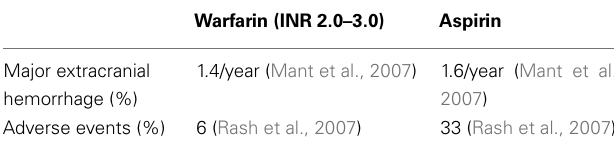
Table 2 |Anticoagulation (warfarin) vs. antiplatelet therapy (aspirin) for stroke prevention in atrial fibrillation in the elderly 49,50